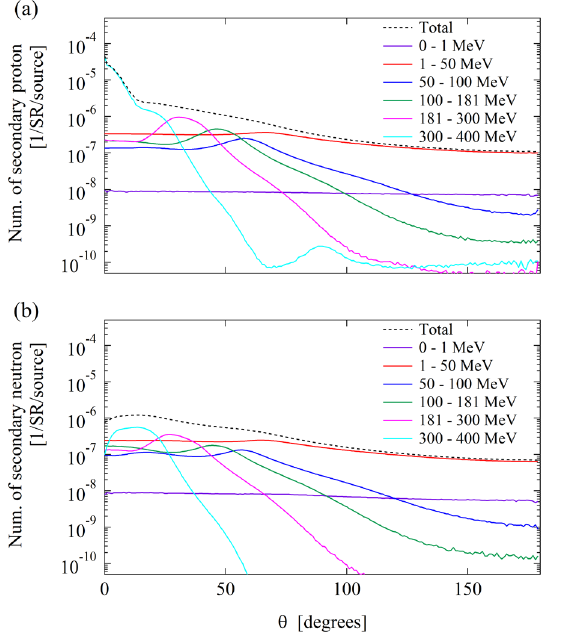
Fig. 6. Angle distribution of secondary proton (a) and secondary neutron (b) with such energy ranges calculated using PHITS